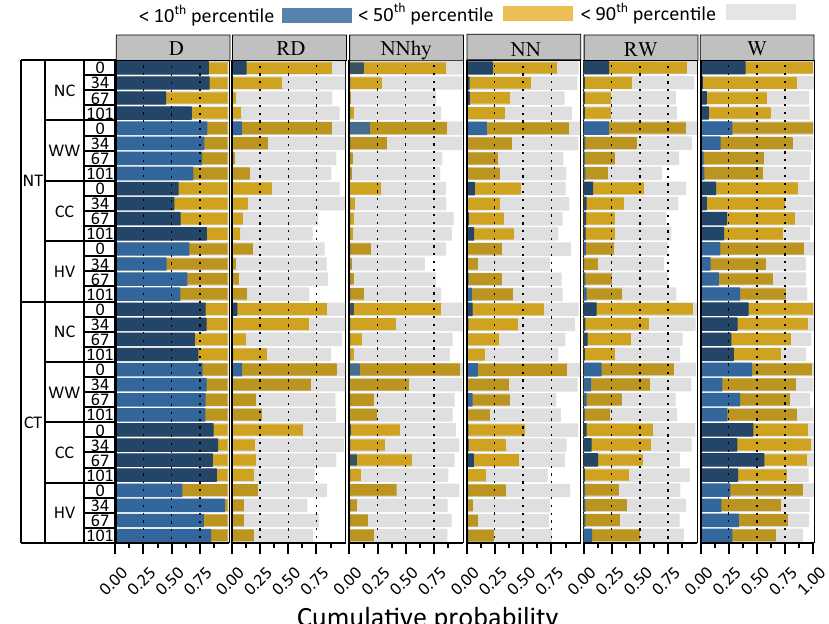
Fig. 4 Cumulative probability of cotton yield losses based on Gaussian distribution below 10, 50, and 90th percentile of the global mean yield across climate conditions. The plots represent the associated values in dry (D), relatively dry (RD), near-normal (NN), high-yielding near-normal (NNhy), relatively wet (RW), and wet (W) years. CT conventional tillage, NT no-tillage, NC no cover crop (control), WW winter wheat, CC crimson clover, HV hairy vetch. SPI and SPEI values during the growing seasons. The blue, yellow, and gray bars represent the cumulative probability of yield losses below 10, 50, and 90th percentile of the global mean yield,